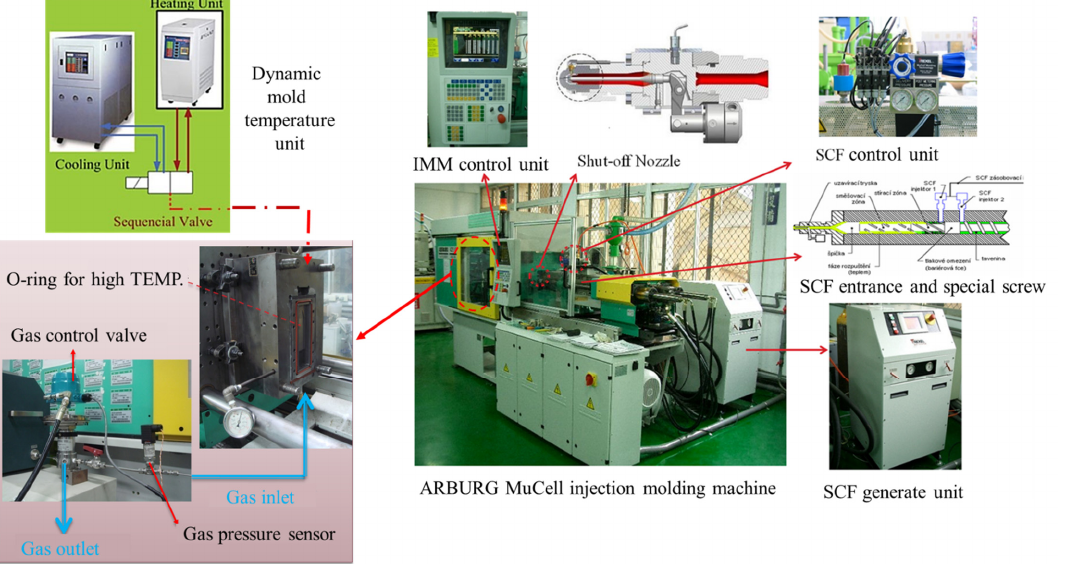
Figure 3. A schematic of MuCell injection molding Unit with a gas counter-pressure (GCP) regulation system and a dynamic mold temperature control system [24].